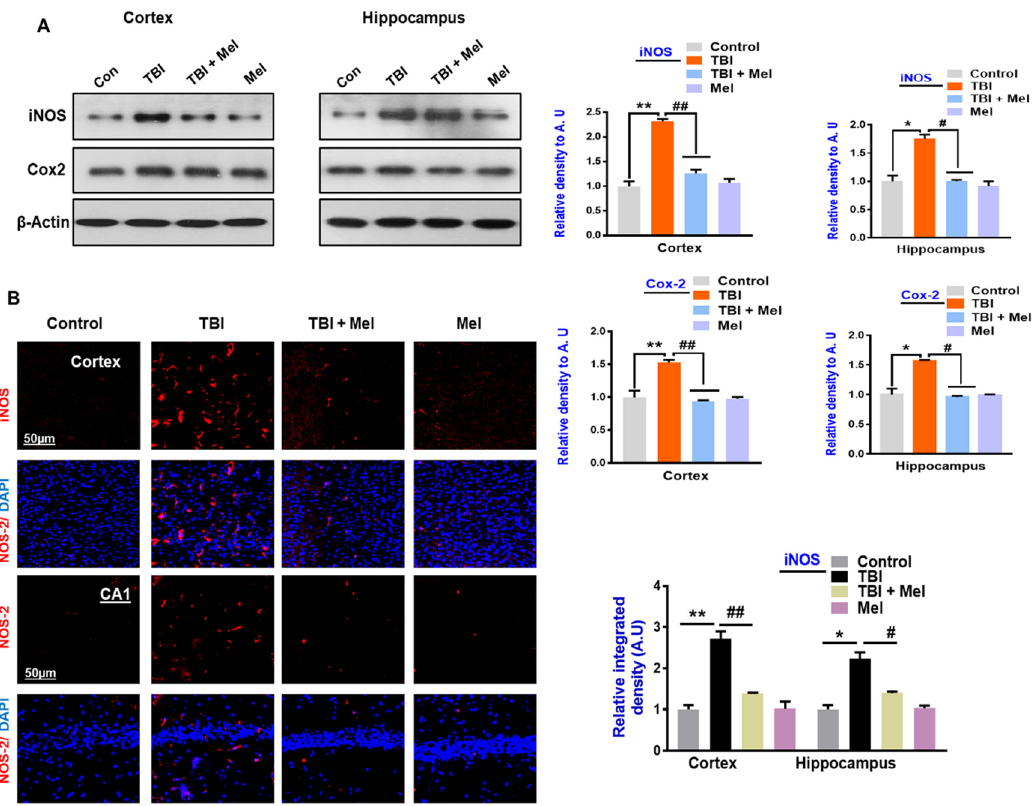
Figure 2. Melatonin regulates the expressions of inducible nitric oxide synthase (iNOS) and cyclooxygenase-2 (Cox-2) in the repetitive mild traumatic brain injury (rmTBI)-mouse model. ( A ) Representative immunoblots and histograms of iNOS and Cox-2 expressions in di ff erent experimental groups, with bar graphs. ( n = 10 mice per group). The beta-actin antibody was used as a loading control. Western blot bands were quantified through SigmaGel software. ( B ) Confocal microscopic results represent iNOS expressions in the di ff erent experimental groups, with respective bar graphs. Magnification 10 × . n = 5 mice per group. Data was taken from three independent experiments. ImageJ software was used for quantitative analysis of the confocal images. The di ff erences have been shown in the graphs. One-way ANOVA followed by post-hoc analysis. * p < 0.05 and ** p < 0.01 represent di ff erence between control and rmTBI, and # p < 0.05 and ## p < 0.01 represent di ff erence between rmTBI plus melatonin (Mel)-treated group.